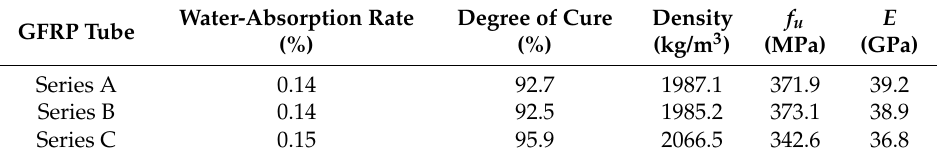
Table 3. Material properties of GFRP tubes.